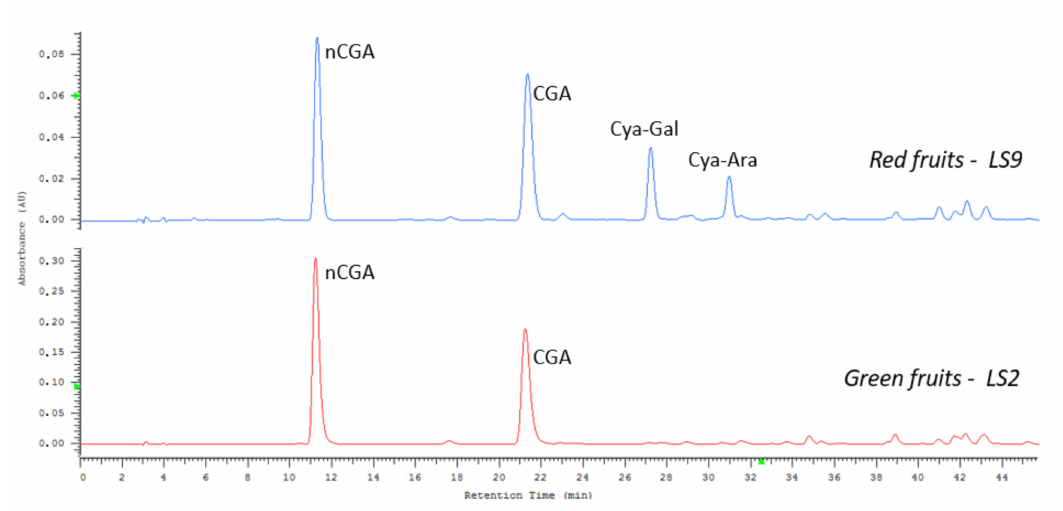
Figure 7. HPLC chromatograms of CGAs in typical green berries and red berries extracts at 330 nm; sample LS2, June and LS9,